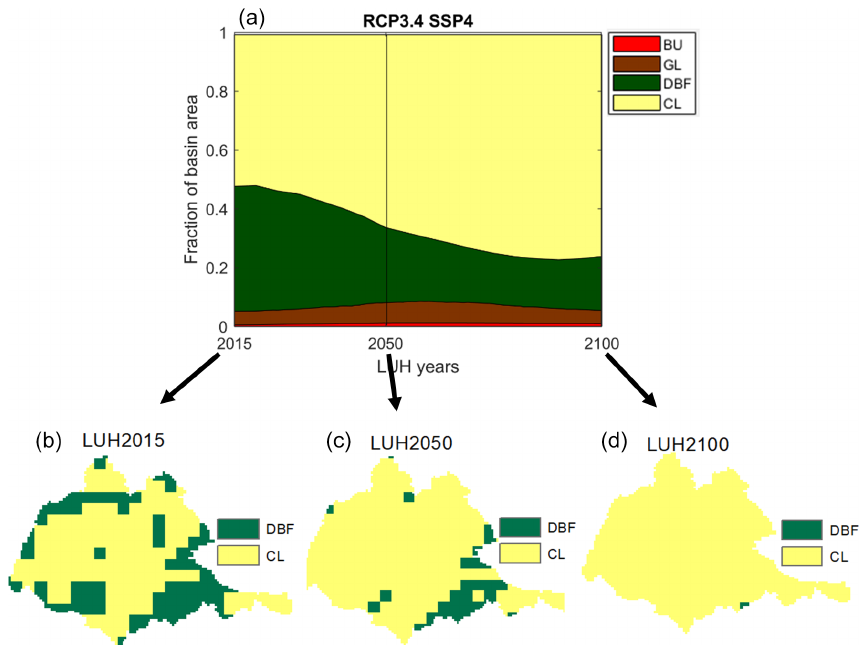
Figure 4. (a) Fraction of catchment area occupied by land use classes for scenario RCP3.4 SSP4. (b–d) Land cover scenarios from LUH2 (resolution – 0.25 ◦ ) for years 2015, 2050 and 2100 used in this study. LUH2 land cover classes shown here are resampled to the model grid resolution, and only the predominant class is shown here for clarity. For actual model simulations, VIC accounts for the individual proportion for each land cover type at each grid